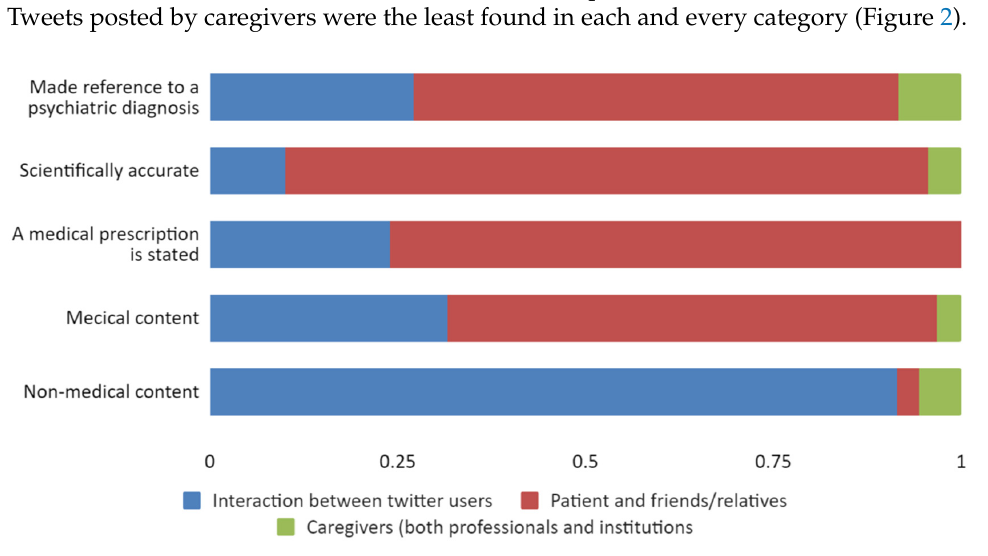
Figure 3. Proportion of type of user by area of clinical interest. On the contrary, interactions between Twitter users were responsible for 91.5% of non-medical content. Of the tweets that trivialized drugs, 99.1% came from this type of user alone. Finally, we would like to point out that almost all tweets posted by caregivers discussed non-medical content, and the most frequent subject in these tweets was of a commercial nature (46.2% of these tweets were posted by this type of user alone) (Figure 4).